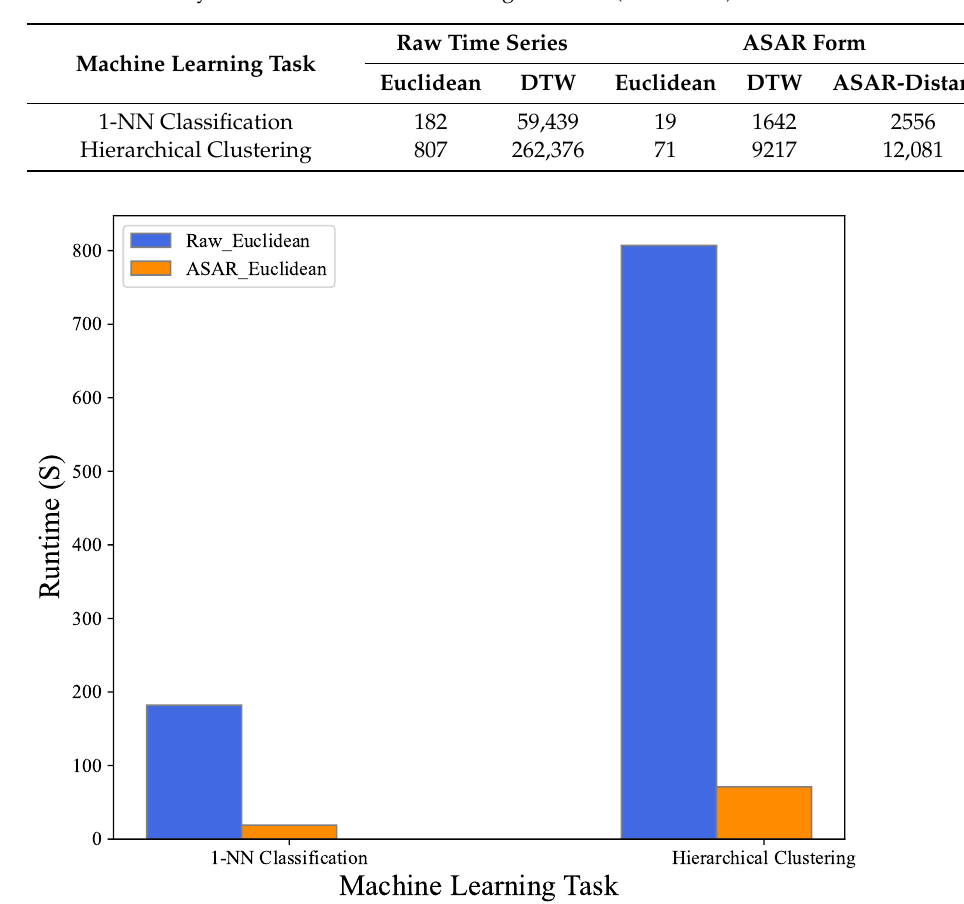
Figure 4. Classification and clustering runtimes for the raw and the ASAR form when using the Euclidean